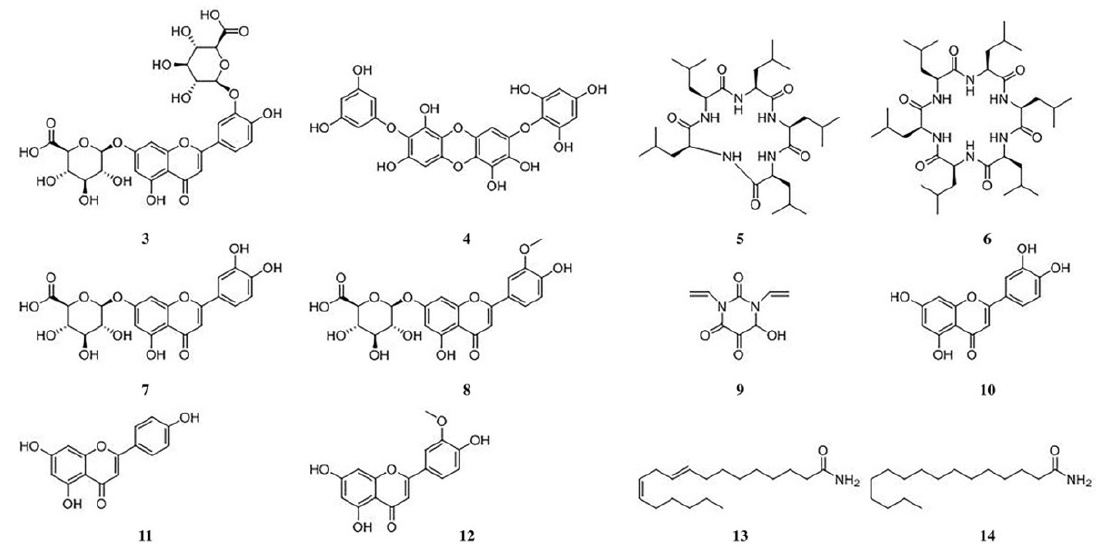
Figure 4. Chemical structures of compounds 3 – 14 (compounds 1 and 2 are unknown).